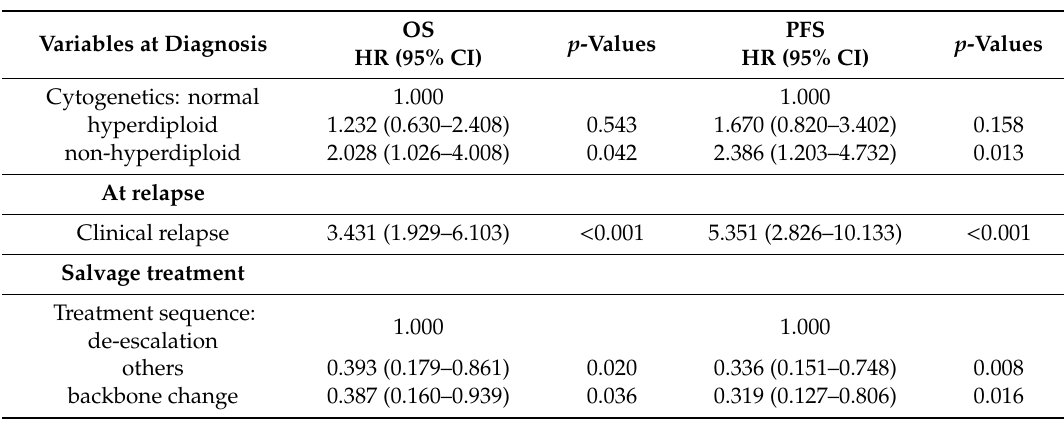
Table 3. Multivariate Cox analysis of the testing cohort.